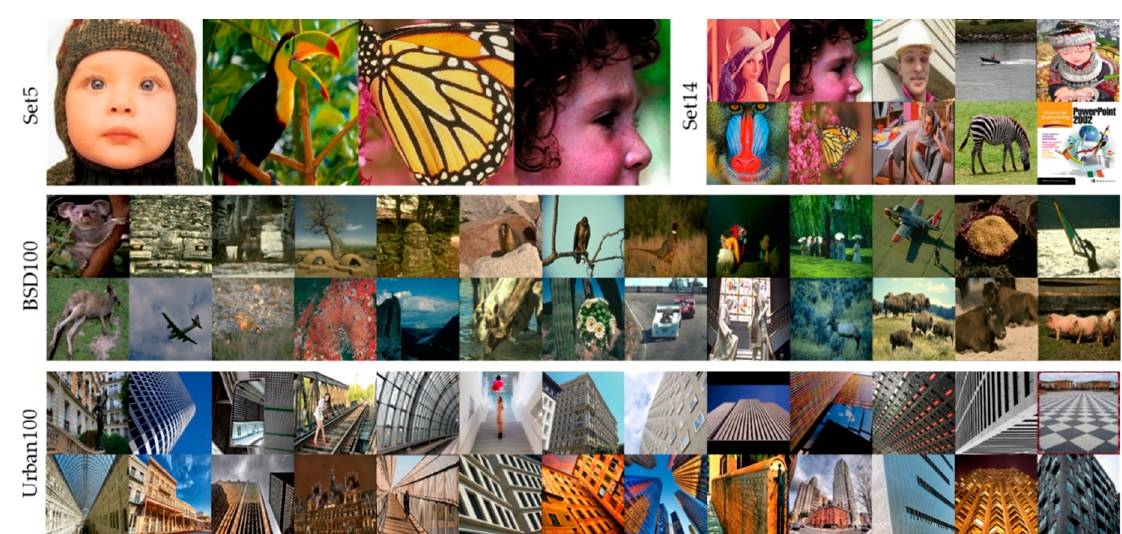
Figure 5. Test datasets. (Set5, Set14, BSD100, and Urban100).